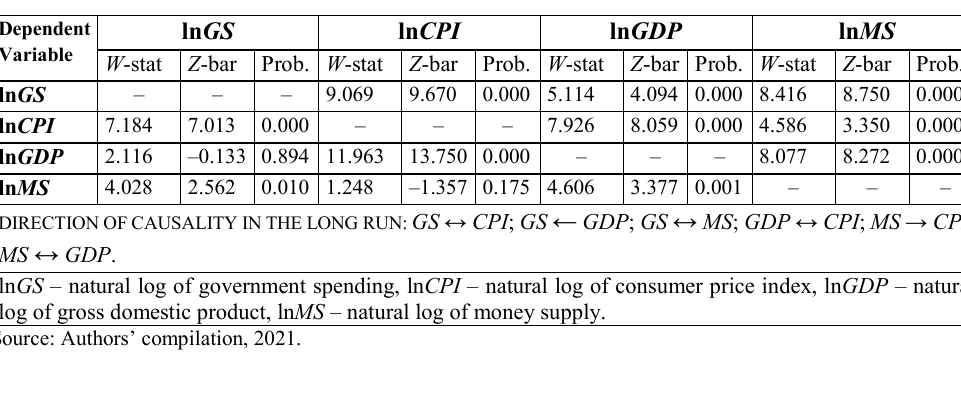
Table 8. Result of Long-Run Causality